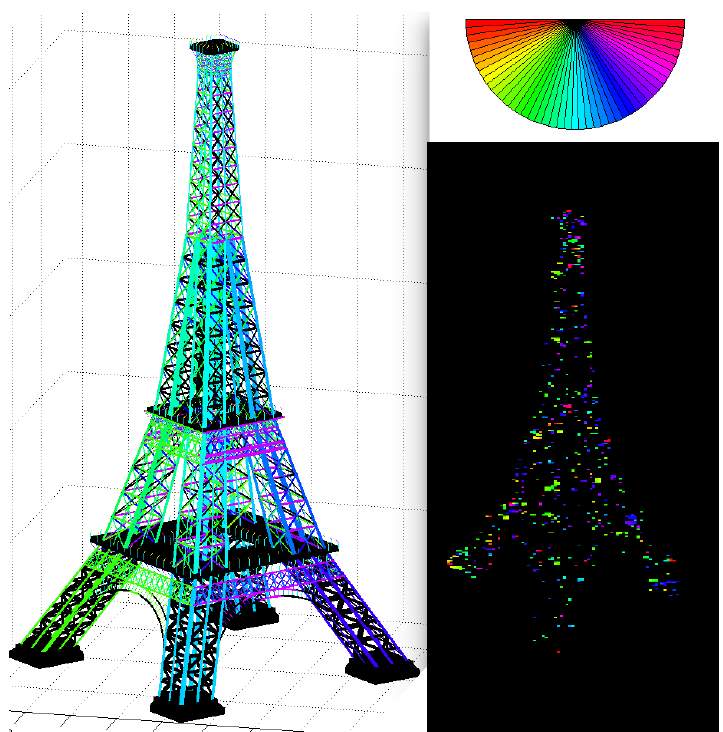
Figure 17. Results of estimation of polarimetric orientation for the Tour Eiffel, compared with orientations of main beams, for stable orientations.